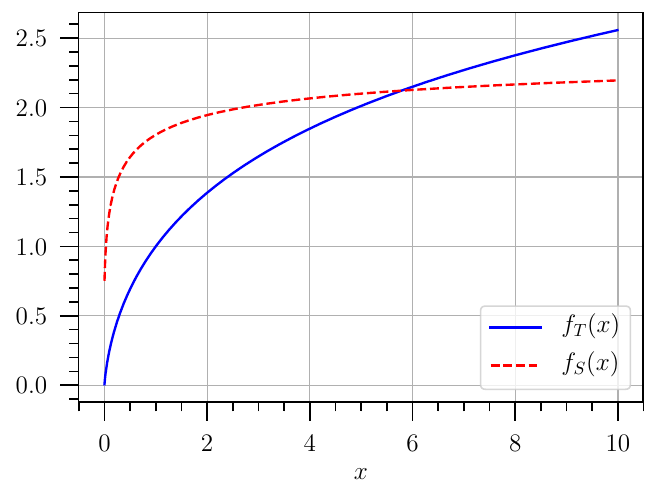
Figure 2 . Loop functions f T ( x ) (solid blue) and f S ( x ) (dashed